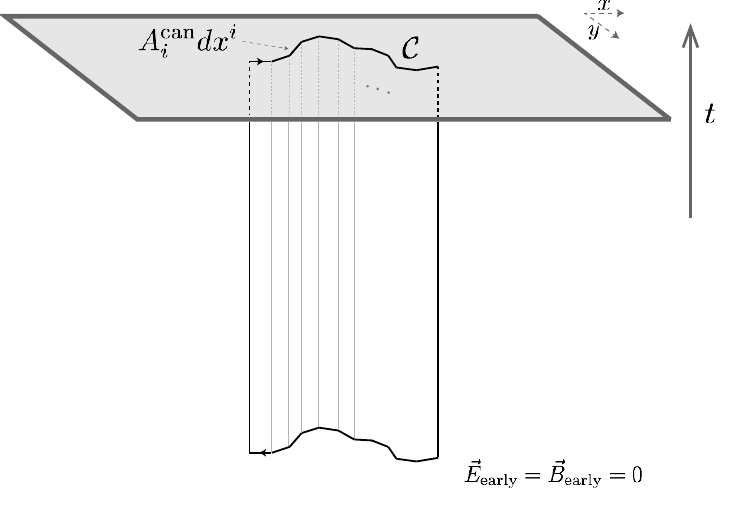
Figure 4. A general CS memory Wilson loop in Mink 3 , comparing parallel transport along the spatial curve C at early and late times, where for simplicity the early state has vanishing gauge (cid:12)eld strength. It can be viewed as composed of many narrow memory Wilson loops, with shared timelike lines canceling due to their opposing orientations. In terms of the canonical CS (cid:12)elds, e(cid:11)ectively in temporal gauge, this general Wilson loop is therefore given by just the late Wilson line along C . (See eq.